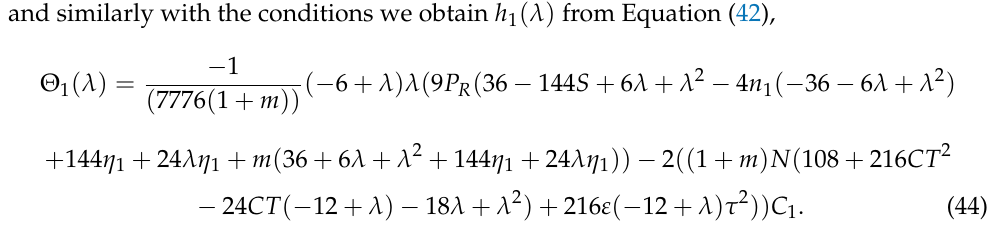
Figure 3. Temperature profile Θ ( λ ) for different choices of magnetic filed parameter M at N = 0.5, m = 1, P R = 6, χ = π τ = 0.6, η u = 0.1, Γ = 2, ε = 1, C T = 0.1, S = 1 showing their exciting nature. ( a ) pure-water. ( b ) Cu-water. ( c )